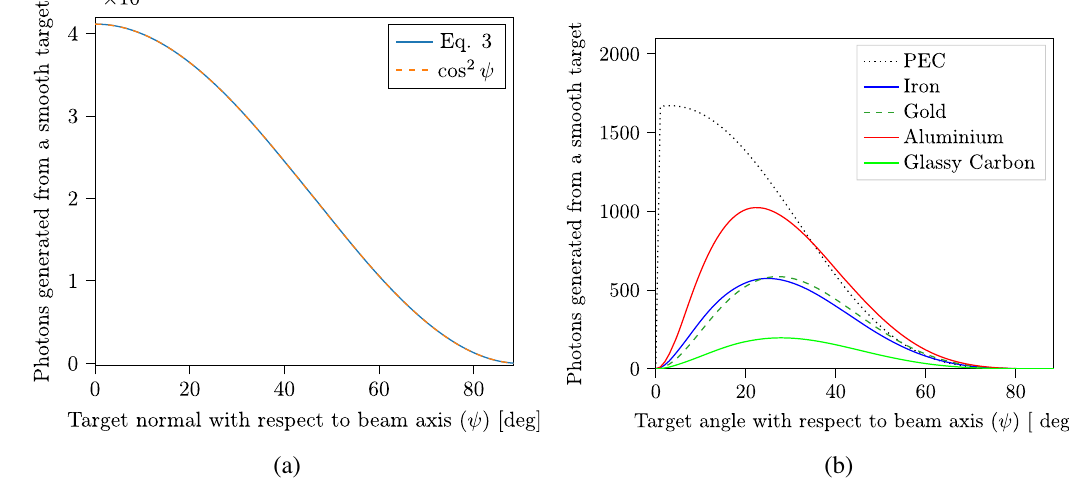
FIG. 5. (a) Total number of photons generated in Δ λ ¼ 300 nm with center at 500 nm in the half sphere as a function of ψ for 5 × 10 9 Ca 10 þ ions. (b) Expected number of photons in 6 × 10 − 4 sr from various target materials as a function of beam incidence with respect to normal ( ψ ) at the observation angle θ ¼ 90 ° − ψ